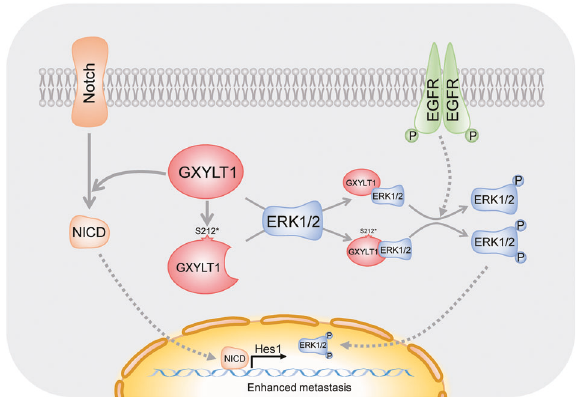
Fig. 8 A schematic model illustrates the potential mechanisms by which GXYLT1 and GXYLT1 S212* promote the metastasis of CRC. GXYLT1 promoted CRC metastasis via the Notch and MAPK pathways, whereas GXYLT1 S212* exhibited stronger metastasis- promoting ability mainly through activating the MAPK